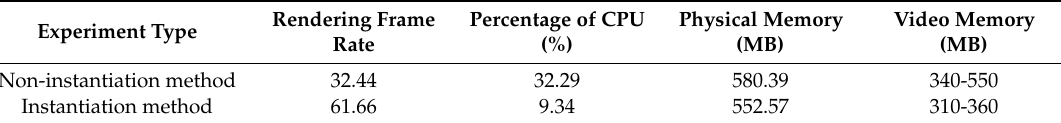
Table 4. The result of benchmark experiment.